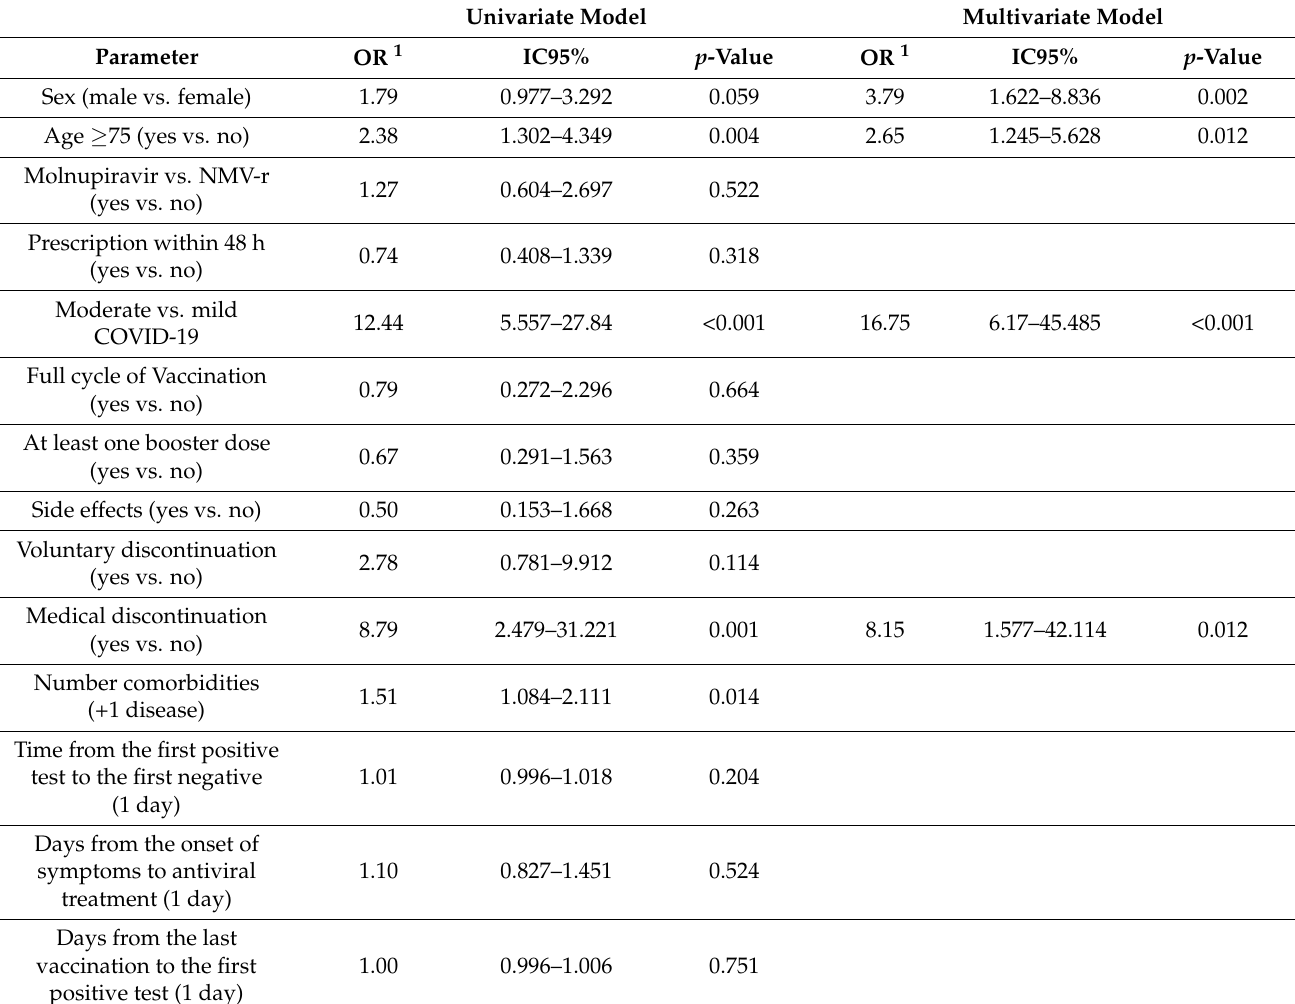
Table 4. Factors associated with the composite outcome (all-cause hospitalization and or death at 30